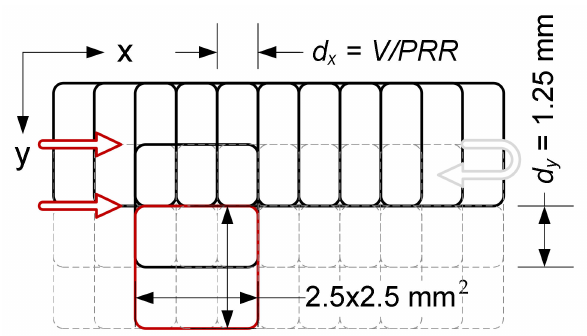
Figure 8. Scheme of unidirectional exposure of PLLA samples (showing the way the pulses overlaps in both directions) with the ArF excimer